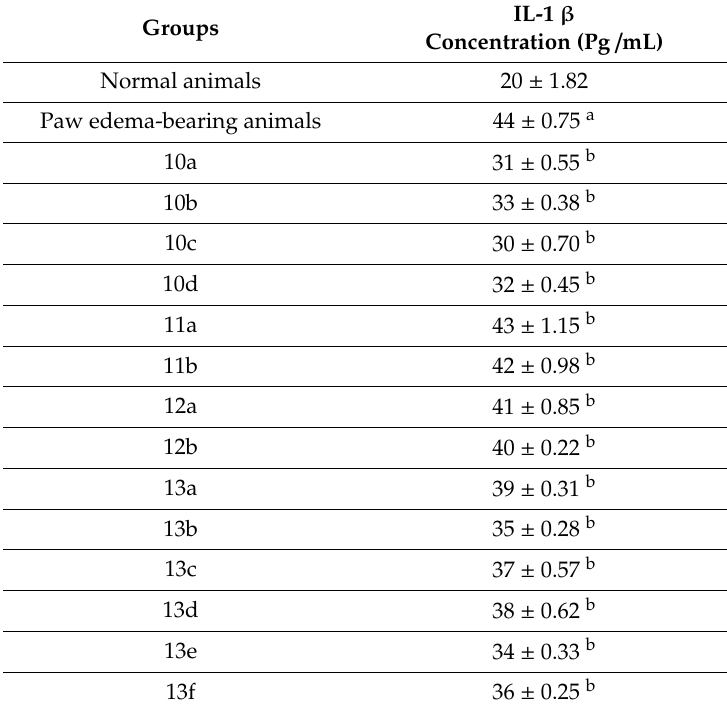
Table 4. Serum level of interleukin-1 beta (IL-1 β ) after paw edema in